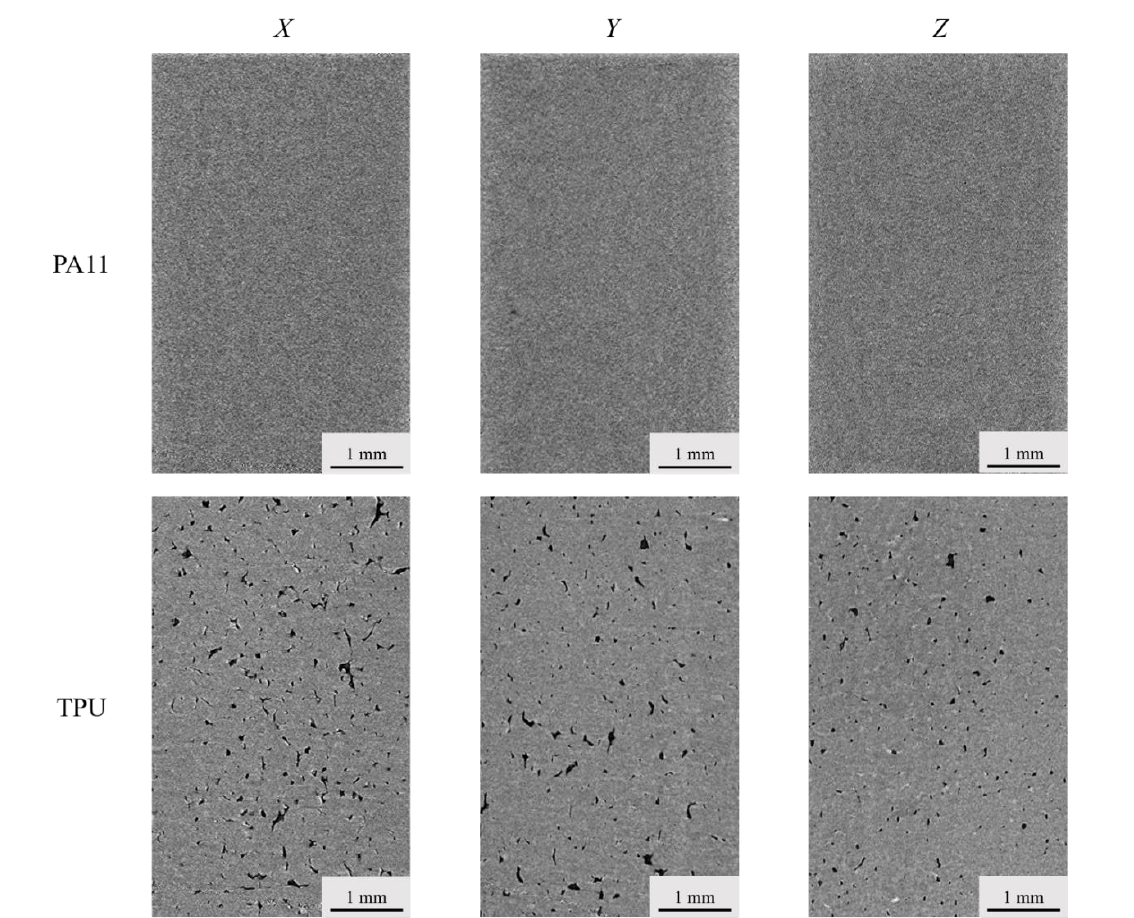
Figure 7. 2D images of PA11 and TPU flexural specimens from micro-CT